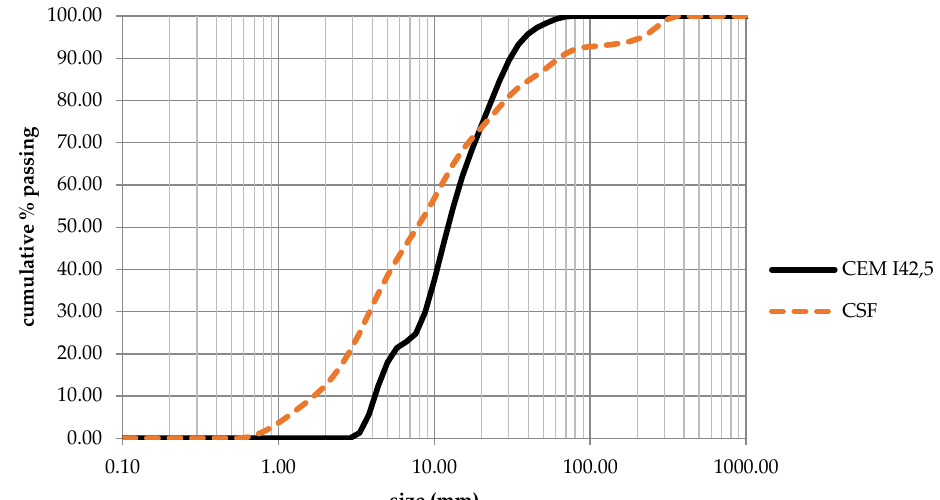
Figure 12. Particle size distribution of CSF and cement.